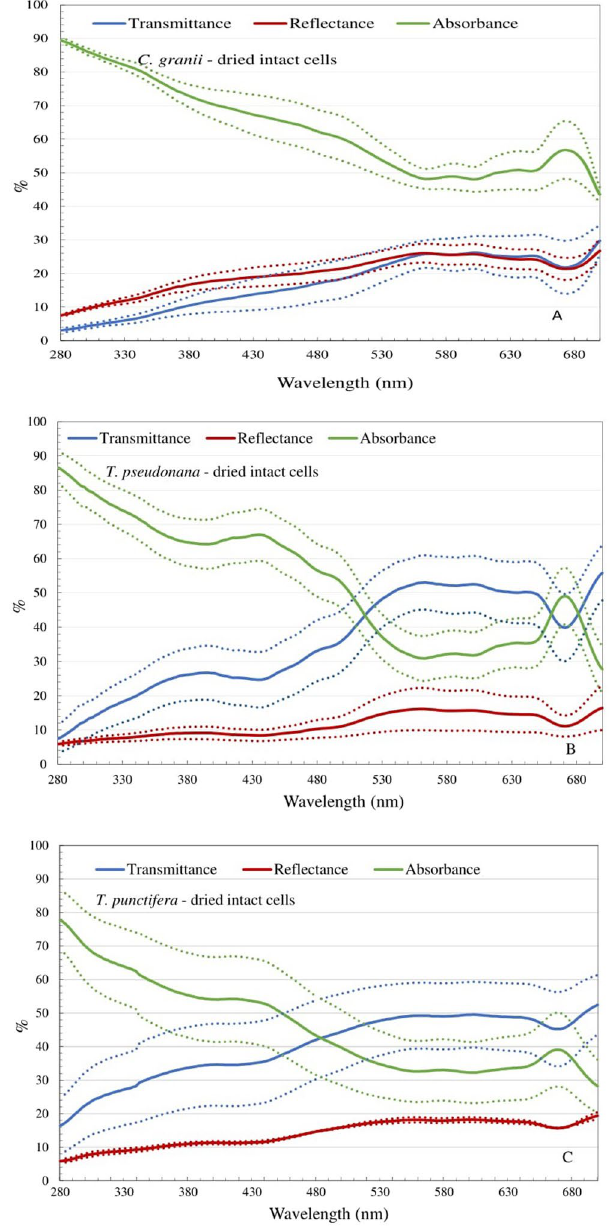
Figure 2. Spectral transmittance (blue), reflectance (red) and absorbance (green) for a coating of dried intact C. granii ( A ), T. pseudonana ( B ) and T. punctifera ( C ) cells. The dotted lines represent the mean value ± the standard deviation. The reference spectrum is the UV-transparent quartz silica microscope glass plate with L1 medium on top of it. All the values are normalized to 100%